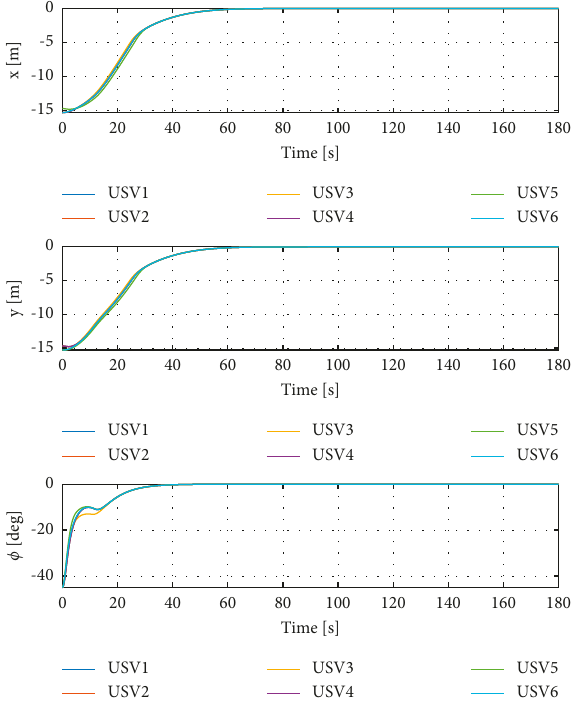
Figure 5: Tracking errors of six follower USVs.